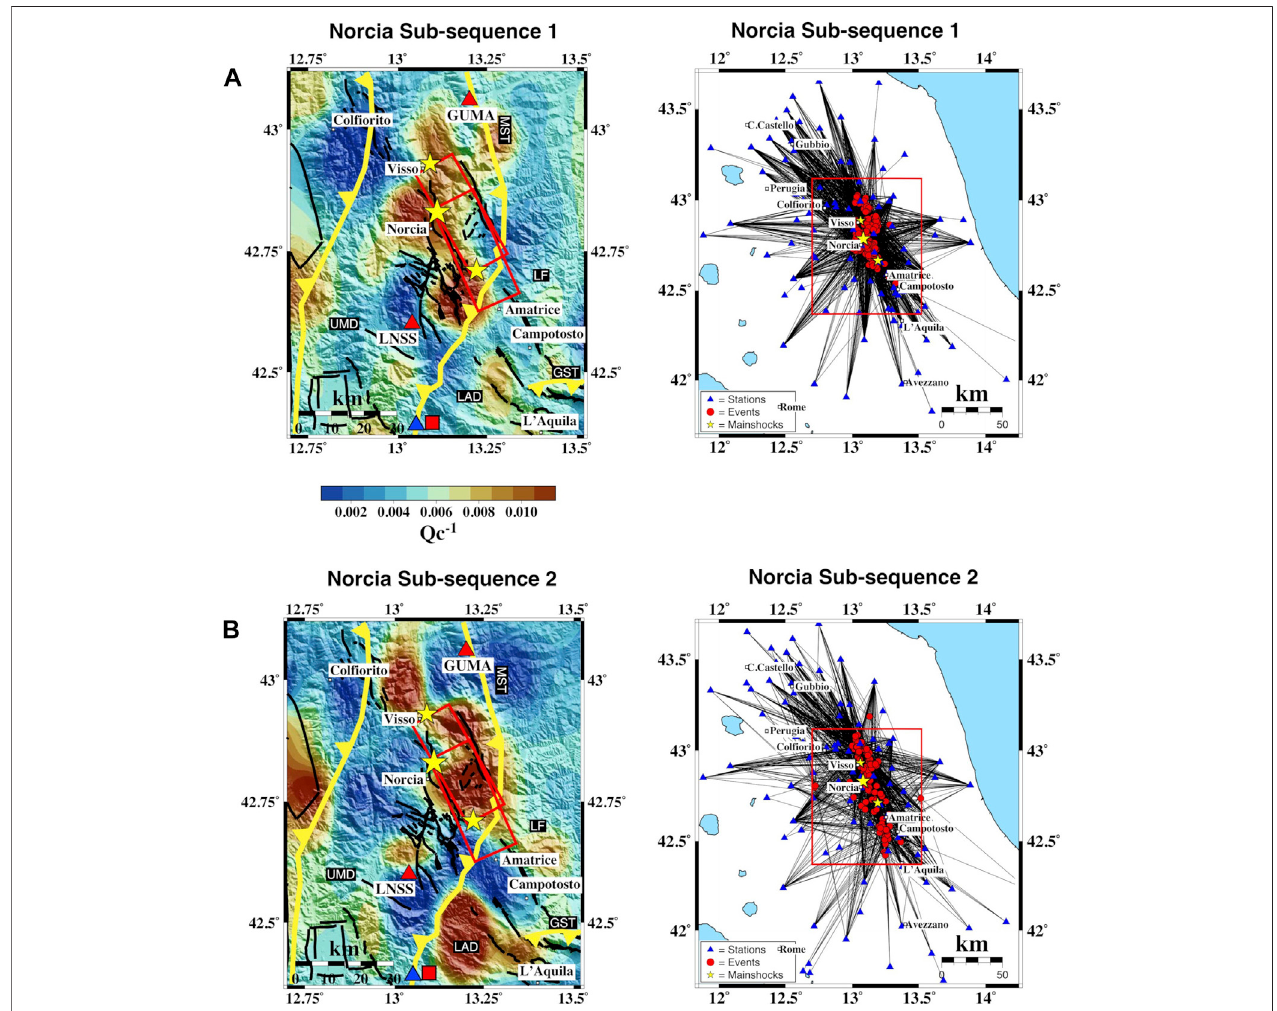
FIGURE8| SpatialvariationofQ c − 1 atf c =1.5 Hzfor (A) NorciaSubsequence-1and (B) Subsequence-2.Redboxesontheleftarethefaultplaneactivatedduring the AVN, and theblack lines are the fault lines from theITHACA catalog. Yellow lines arethe main thrustof the area. The main thrusts are highlighted: MST, Monti Sibillini thrust; GST, Gran Sasso thrust. The red square and the blue triangle are the Velino and Canetra springs ’ locations, respectively. The stars indicate the 2016 – 2017 mainshock. On the right, blue triangles are the seismic stations and red circles are the seismic events. Red boxes show the restricted area on the left.